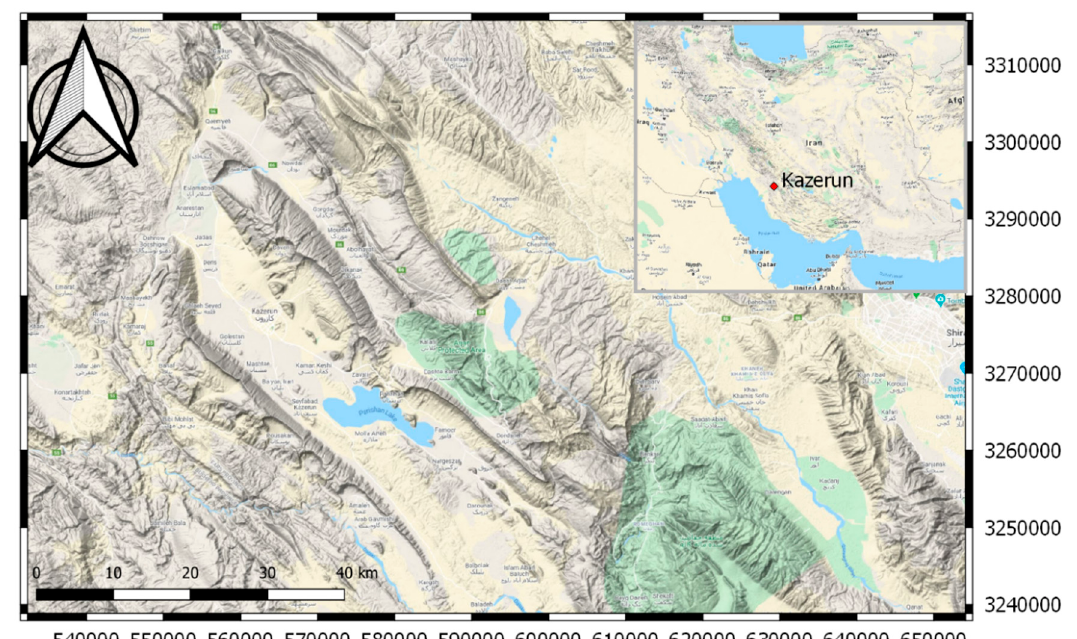
Figure 1. Location of the observed area (modified from [31]).